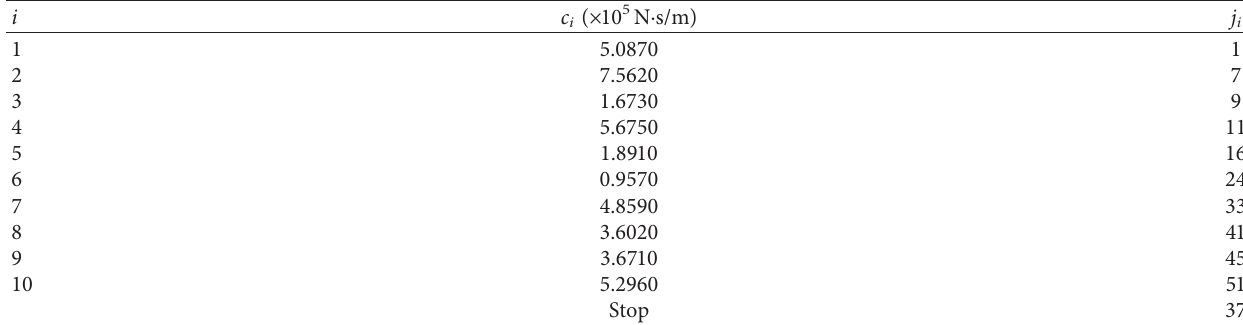
Table 8: Distribution of the coefficients of damping of the compliant ground.